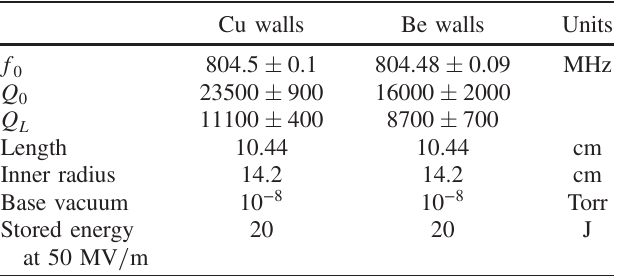
TABLE II. Operating parameters for the Modular Cavity. Quoted uncertainty in reported values is the standard deviation across mount/demount endplate cycles, giving an indication of repeatability of experimental conditions. The cavity length is based on a π = 2 phase advance for v=c ≈ 0 . 85 muon